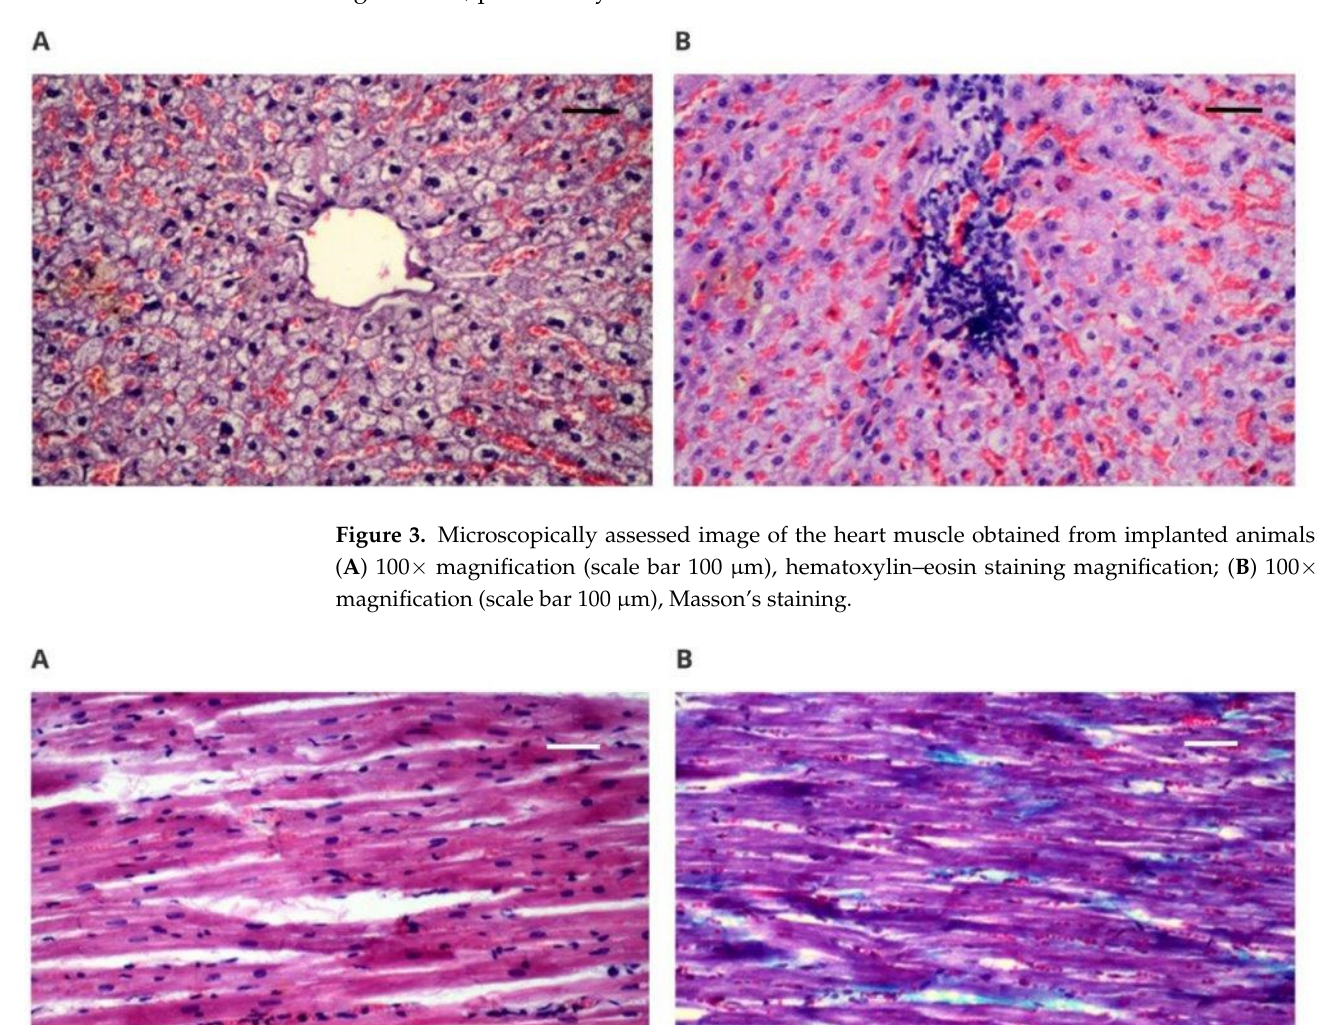
Figure 5. Microscopically assessed image of the spleen collected from animals with implants: ( A ) 50× magnification (scale bar 200 µm), Masson’s staining, white pulp; ( B ) 50× magnification (scale bar 200 µm), Masson’s staining, red pulp. In the histopathological examinations of the lung specimens, which includes both the right and left lung, the dominant image showed a variable intensity of hyperemia, usually with slight edema; therefore, in order to determine whether the circulatory disorders are acute—related to euthanasia or chronic, long-lasting disorders—observations were made